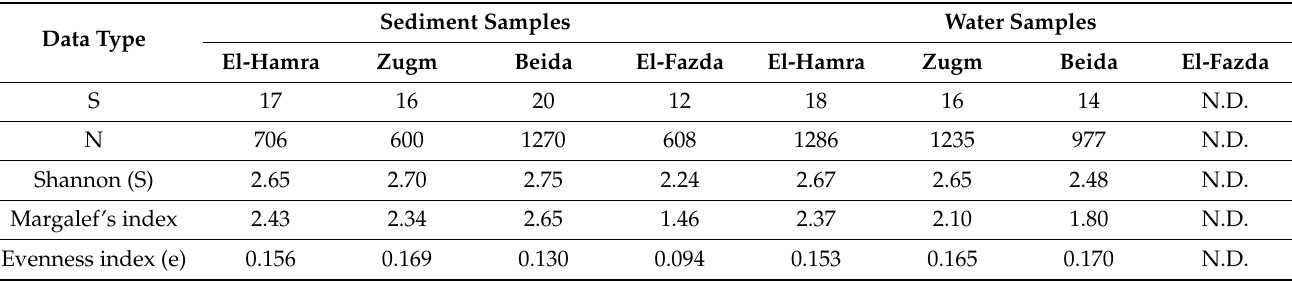
S, total number of species (bands). N , total number of individuals (relative band intensity) N.D. , not